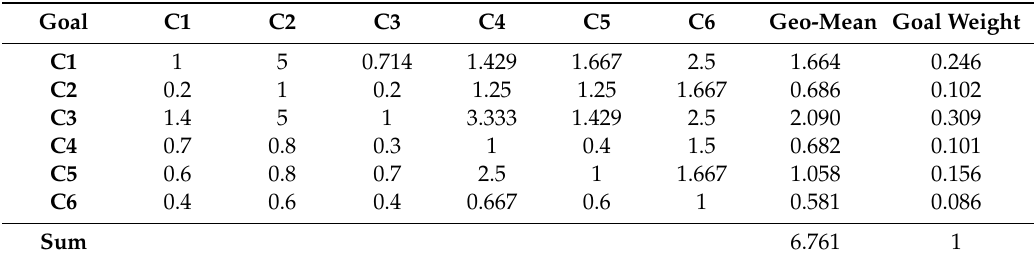
Table 4. Criteria pairwise comparison to goal.